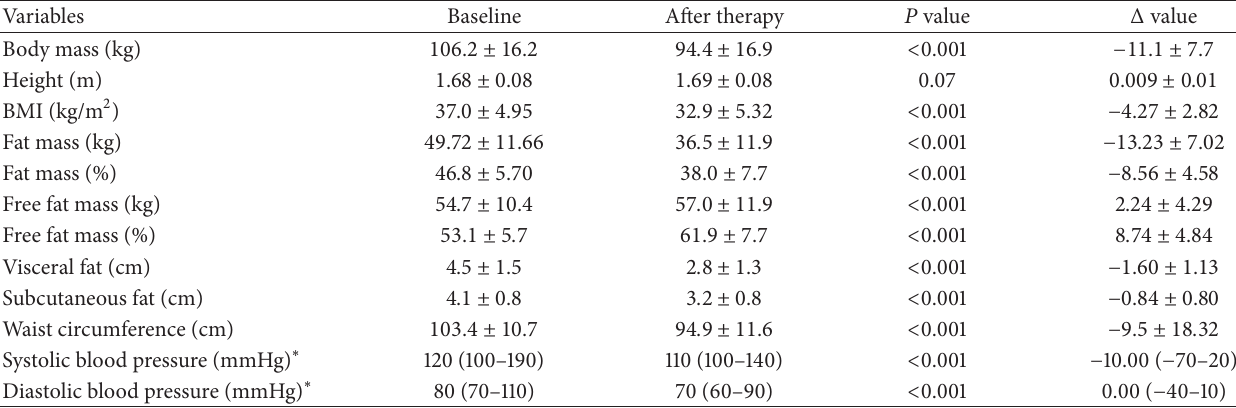
Table 2: Effects of interdisciplinary therapy in body composition.